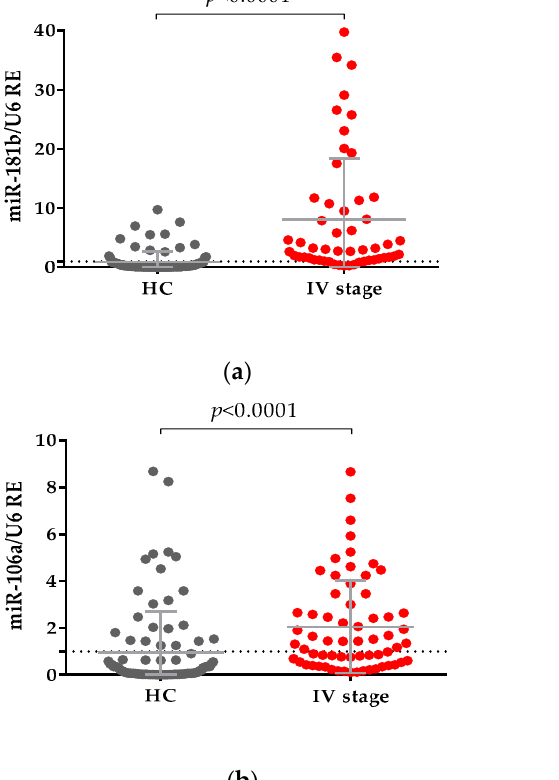
( b ) Figure 6. ( a ) Correlation between the expression levels of miR-181b and hsa_circ_0001445 in plasma of CRC in stage IV. ( b ) Correlation between expression levels of miR106a and hsa_circ_0007915 in plasma of CRC in stage IV. Spearman cor- relation was used to identify the correlation between the levels of miRNAs and circRNAs in plasma. 3. Discussion Finding noninvasive diagnostic, prognostic or predictive biomarkers in the blood is a constant target in cancer studies. In recent years great hopes have been placed on lncRNAs and, especially, on circRNAs because of their association with clinicopathologi- cal characteristics of cancer patients and their stability in circulation. Similar to the other types of ncRNAs, circRNAs can act as oncogenes or tumor suppressor genes and are as- sociated with cancer phenotypes [29,39].